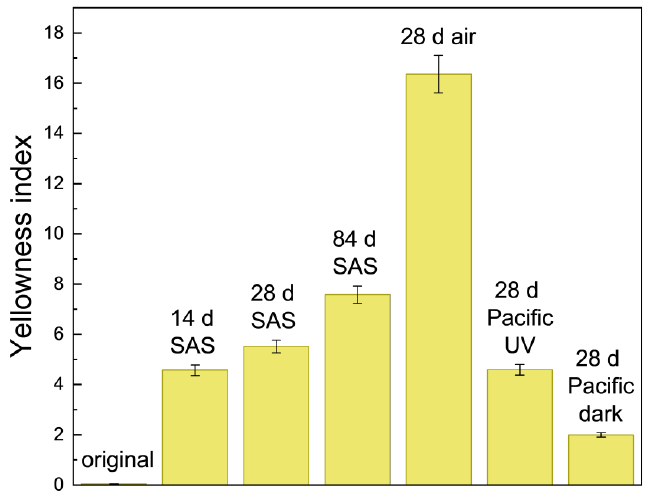
Figure 7. Yellowness index illustrating the degree of yellowness of the lab-weathered samples (14, 28, and 84 days in SAS and 28 days in air) and of the 28-day naturally weathered samples with and without UV irradiation after cleaning in comparison with a non-weathered original PET sheet.